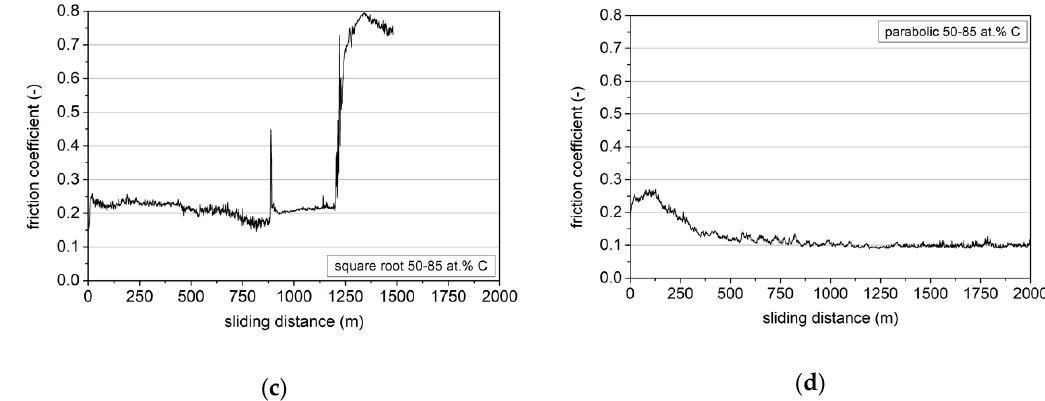
Figure 15. Dependence of the friction coefficient on the sliding distance during ball-on-disk test of gradient Zr–C coatings with ( a ) square root carbon content profile in the range of 0–50 at.%, ( b ) parabolic carbon content profile in the range of 0–50 at.%, ( c ) square root carbon content profile in the range of 50 to 85 at.%, ( d ) parabolic carbon content profile in the range of 50 to 85 at.%.